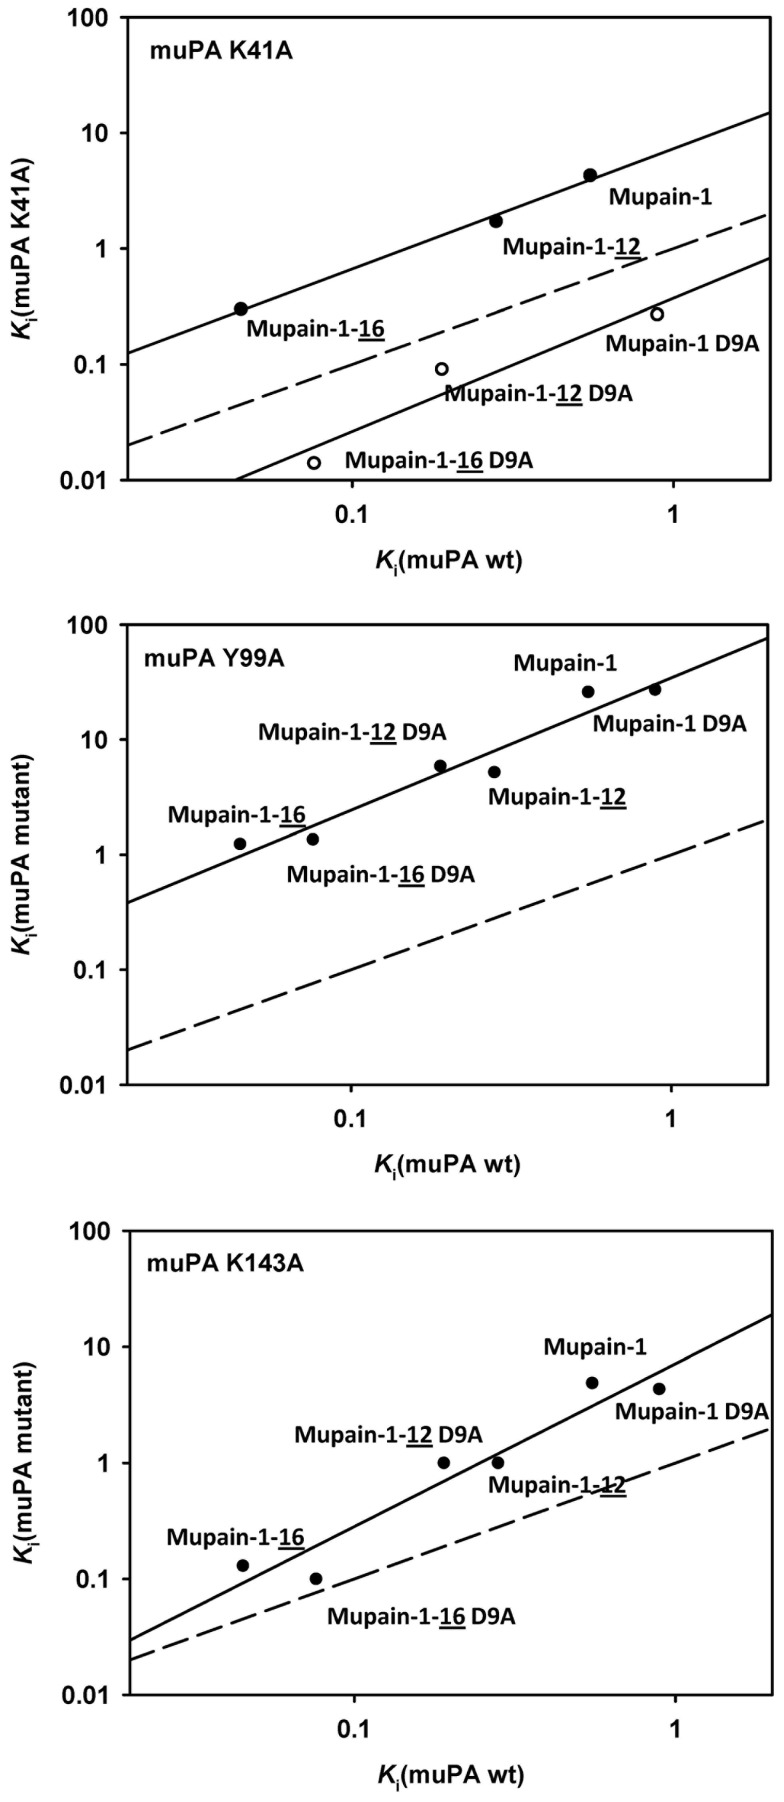
The relationship between the K
i values for inhibition of muPA exosite mutants and the K
i value for inhibition of muPA wt.The figure is based on the K
i values presented in Table 5. The x-axes show the K
i values for inhibition of muPA wt by the indicated peptides. The y-axes shows the corresponding K
i values for inhibition of muPA K41A, Y99A, or K143A. The lines resulted from simple linear regression analysis. The slope of the lines are 1.04 (muPA K41A with Asp9 peptides); 1.15 (muPA K41A with Ala9 peptides); 1.15 (muPA Y99A); 1.40 (muPA K143A). The stippled line shows the line which would have resulted if the K
i values for exosite mutants and muPA wt had been identical (y = x).